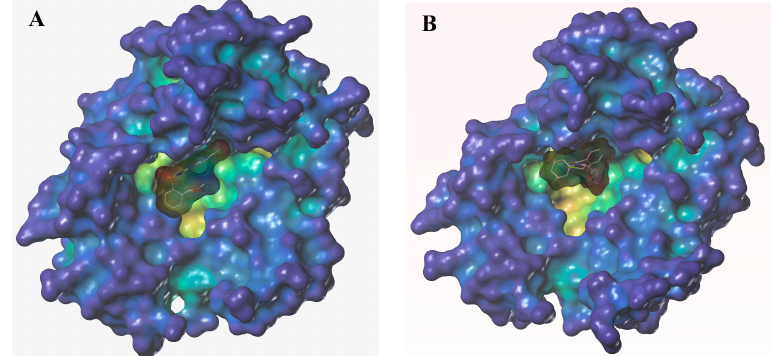
Figure 3 . Docking modeling of chlorimuron-ethyl ( A ) and 4e ( B ) with ALS. Figure 3. Docking modeling of chlorimuron-ethyl ( A ) and 4e ( B ) with